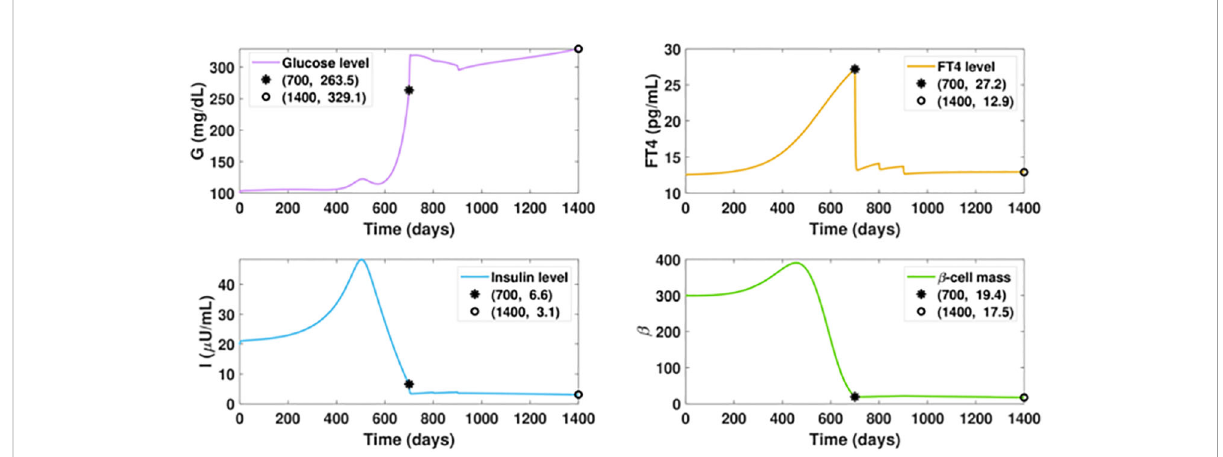
FIGURE 8 Dynamics of altered glucose, insulin, and functional beta-cell mass levels with belatedly treated hyperthyroidism. The ATD dosage D is designed as a piecewise function in the following pattern: D = 0, for t ≤ 700; D = 12, for 700< t ≤ 800; D = 15, for 800< t ≤ 900; D = 20, for t > 900. All the other parameter values and initial conditions remain the same as those in Figure 7. The anti-hyperthyroid treatment starts at day 700, when the beta-cell defect already occurred. Although the FT4 level sharply decreases and approaches the set point value after day 1000, there is no apparent mitigation of diabetes, which is in signi fi cant contrast with the outcome of timely treated